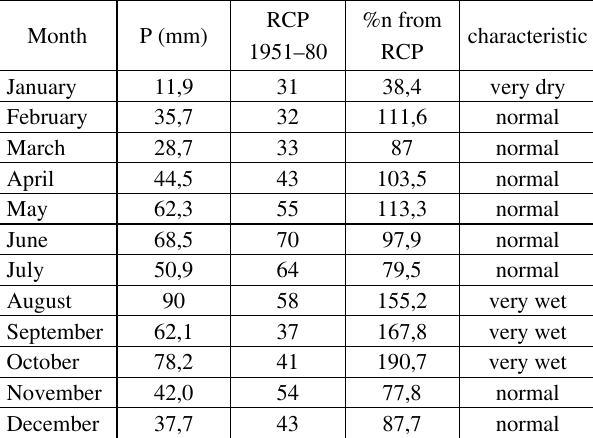
Table 1 . Evaluation of months according to rain reference cli- mate period (RCP) 1951–80 in Nitra for 2002